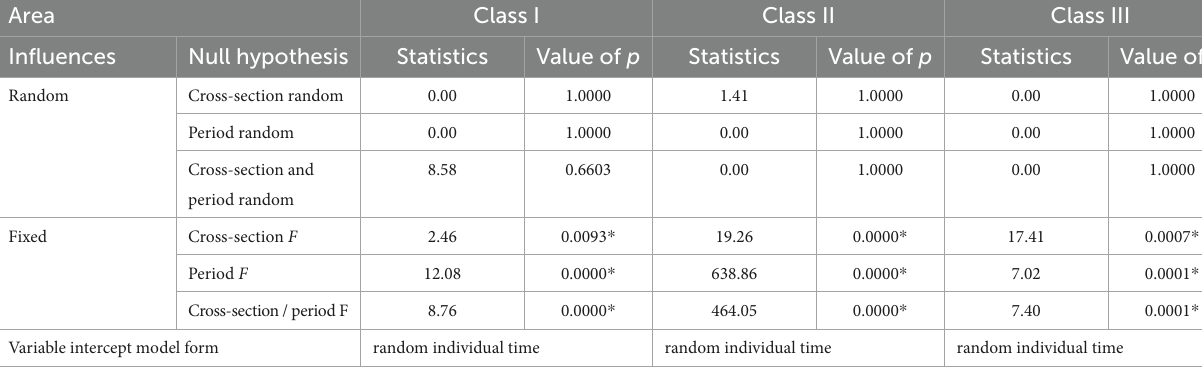
TABLE 7 Formal test results of variable coefficient models in each region.